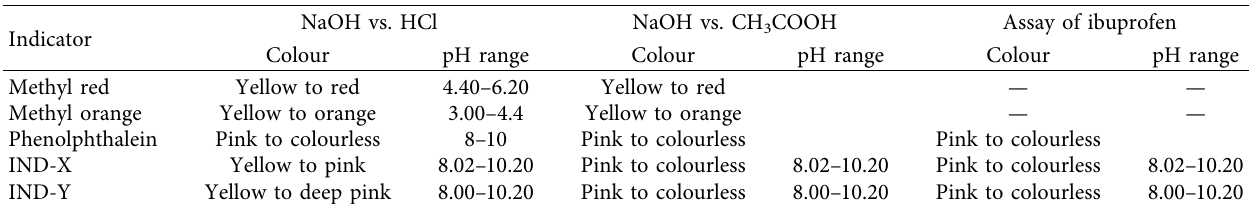
Table 2: Colour changes and pH ranges were observed during titrimetric analysis.